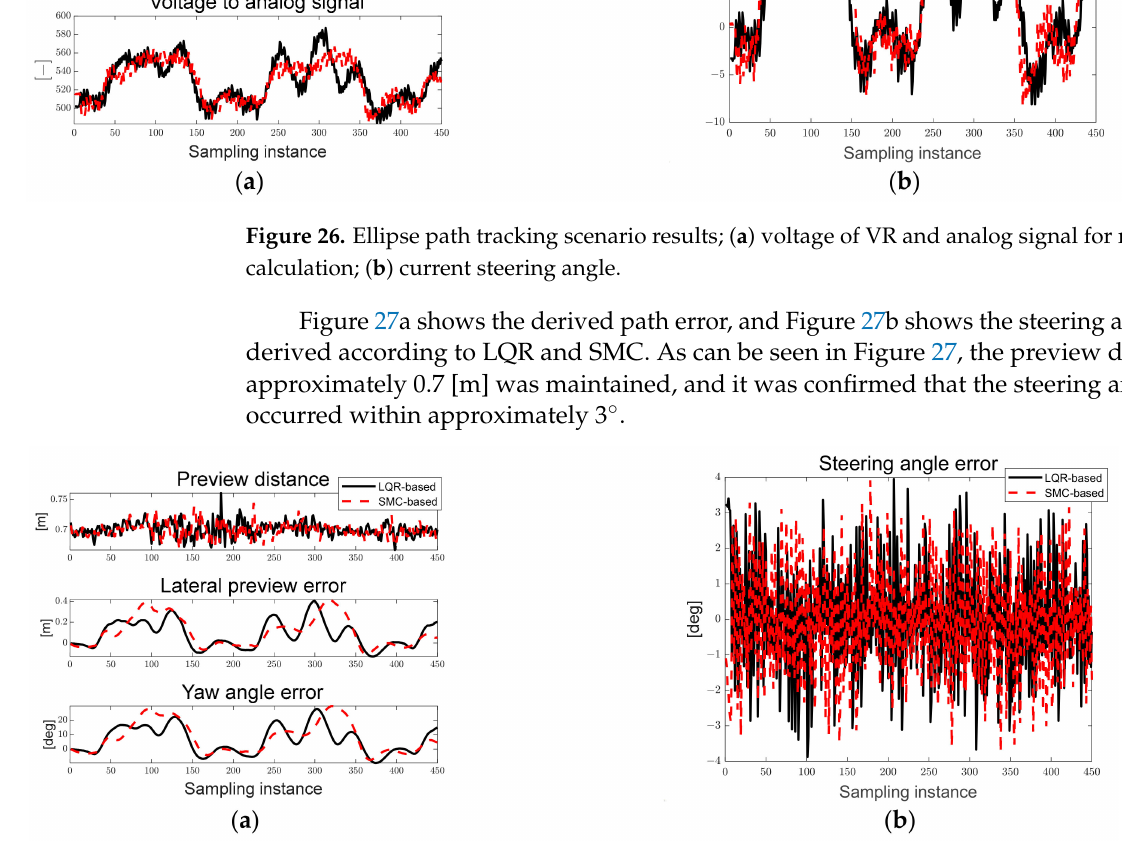
Figure 27. Ellipse path tracking scenario results; ( a ) path errors: preview distance, lateral preview and yaw angle errors; ( b ) steering angle